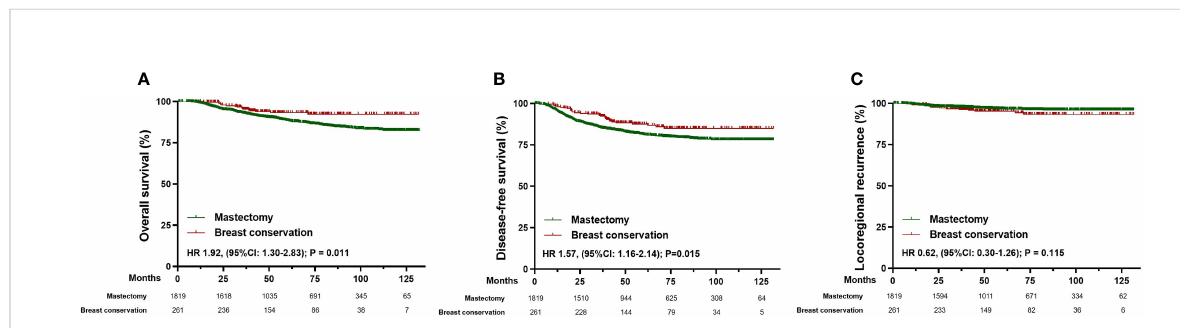
FIGURE 3 Survival analysis in the total cohort of patients receiving mastectomy (n=1819) and breast conservation (n=261). (A) Kaplan-Meier curves for overall survival analysis in patients of different surgical groups. (B) Kaplan-Meier curves for disease-free survival analysis in patients of different surgical groups. (C) Kaplan-Meier curves for locoregional recurrence analysis in patients of different surgical groups. HR, Hazard ratio; 95% CI, 95% con fi dence